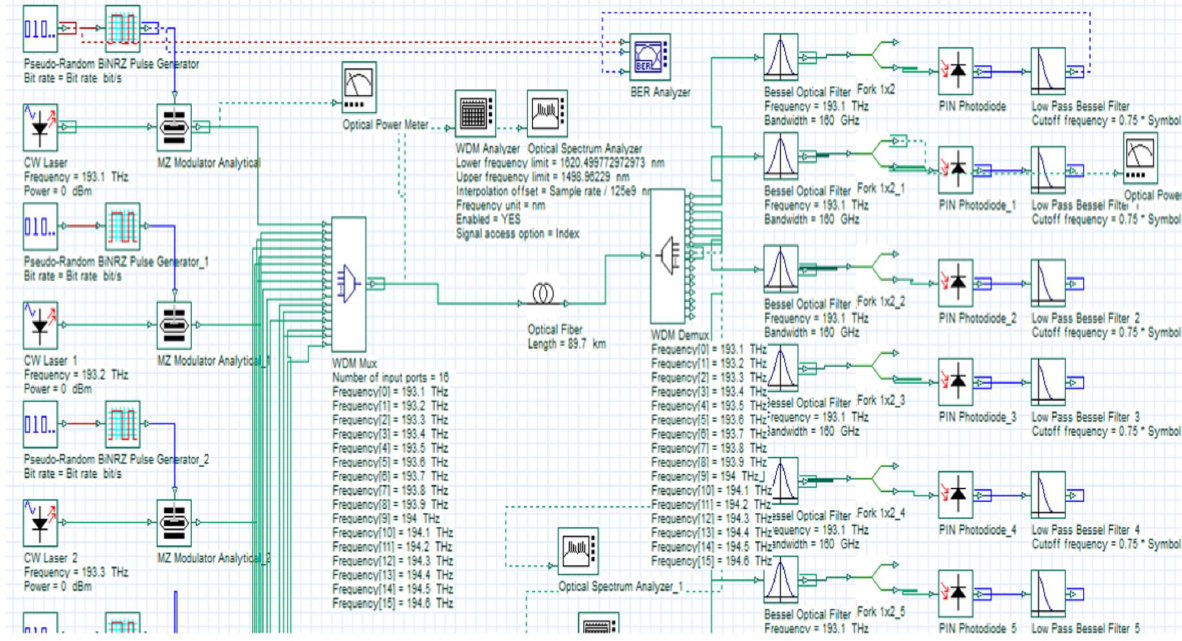
Figure 2. Model view of a 16 channel WDM system (due to complexity only part of the system is shown)